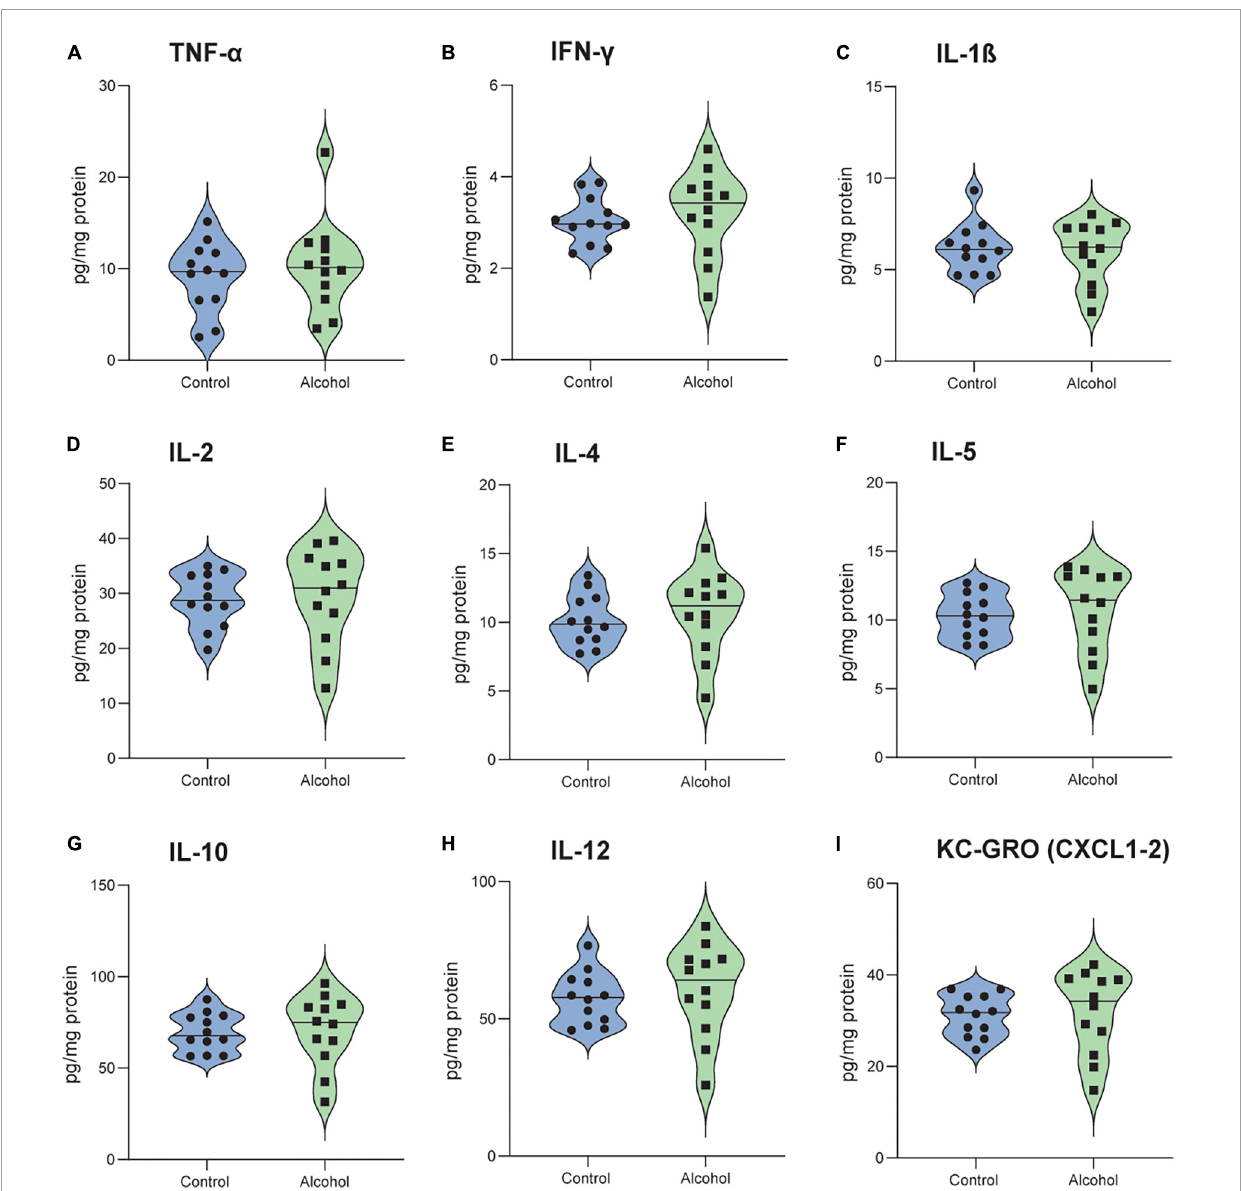
FIGURE9 No detectable neuroinflammation following alcohol exposure in C3H mice. The brain levels of TNF- α (A) , IFN- γ (B) , IL-1 β (C) , IL-2 (D) , IL-4 (E) , IL-5 (F) , IL-10 (G) , IL-12 (H) and KC-GRO (I) in C3H mice. Data are shown as individual subjects with violin plots. n = 12 per